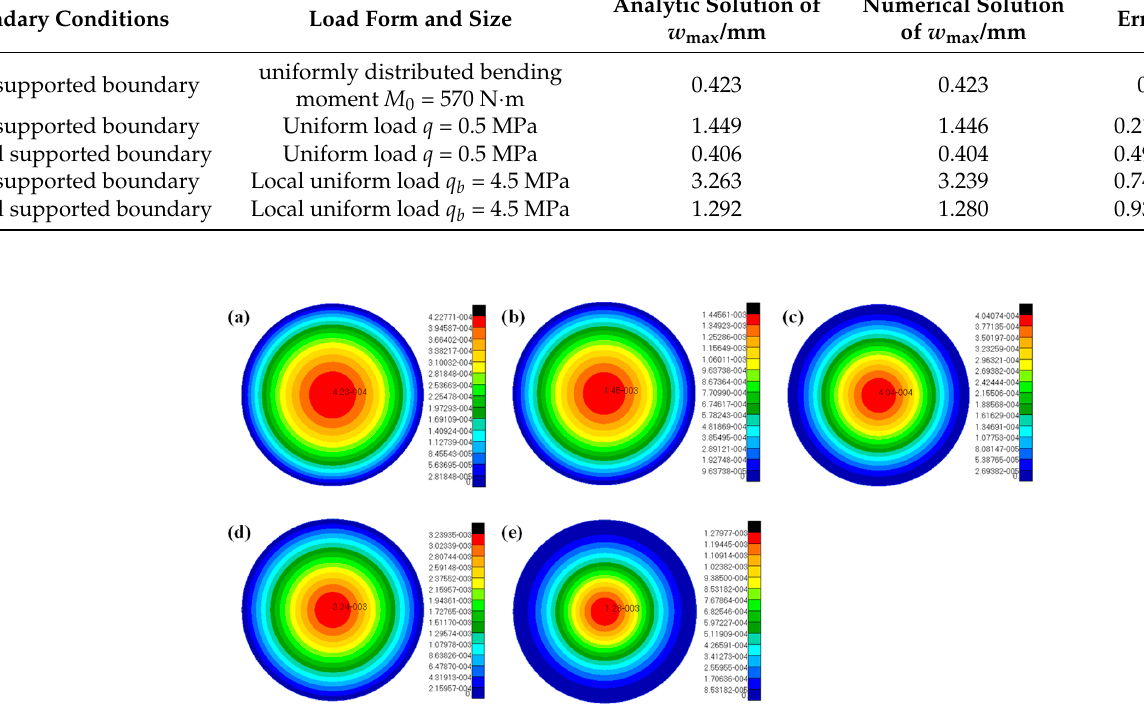
Figure 4. The distribution cloud chart of bending deformation of the circular SP-HC under different loads and boundary constraints: ( a ) simply supported boundary, uniformly distributed bending moment M 0 = 570 N . m; ( b ) simply supported boundary, uniform load q = 0.5 MPa; ( c ) fixed-end supported boundary, uniform load q = 0.5 MPa; ( d ) simply supported boundary, local uniform load q b = 4.5 MPa; and ( e ) fixed-end supported boundary, local uniform load q b = 4.5 MPa.